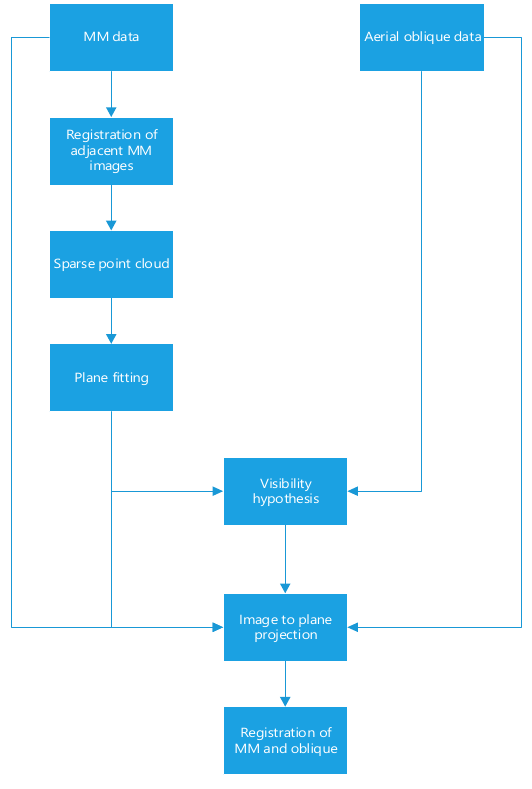
Figure 1. MM to oblique image registration pipeline